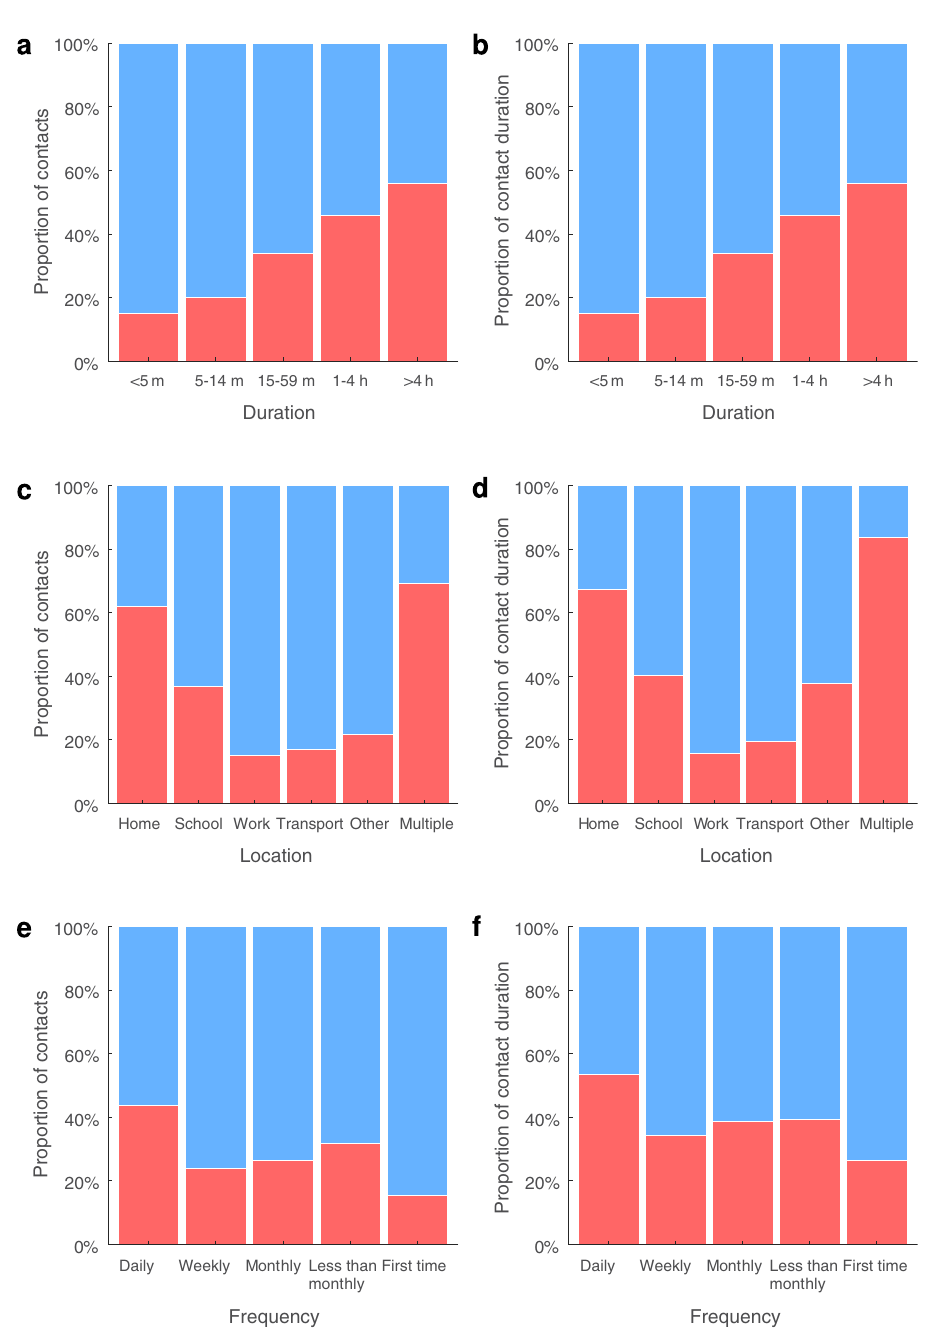
Figure 3. The proportion of contacts and contact duration involving physical contacts. The proportion of contacts and contact duration (in person hours) that were physical or non-physical by ( a , b ) duration, ( c , d ) location, and ( e , f ) frequency of